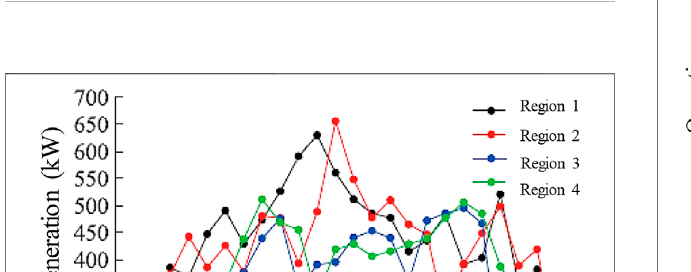
FIGURE 8 | Comparison of power optimization of the fi rst region.